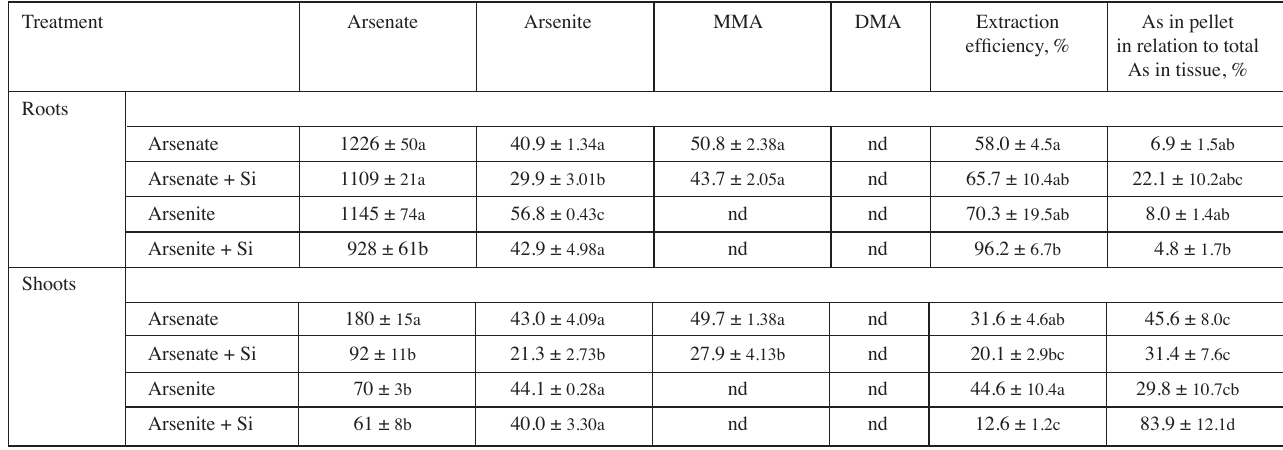
Tab. 4: Concentration of various As species (μg g –1 DW) in roots and shoots of lettuce after treatment with 10 μM arsenite or arsenate with or without 1 mM potassium silicate for four days. Indicated here is As in pellets left after extraction for As species in relation to total As in tissue as well as the extraction efficiency of arsenite species; n = 4, ±SE, nd = not